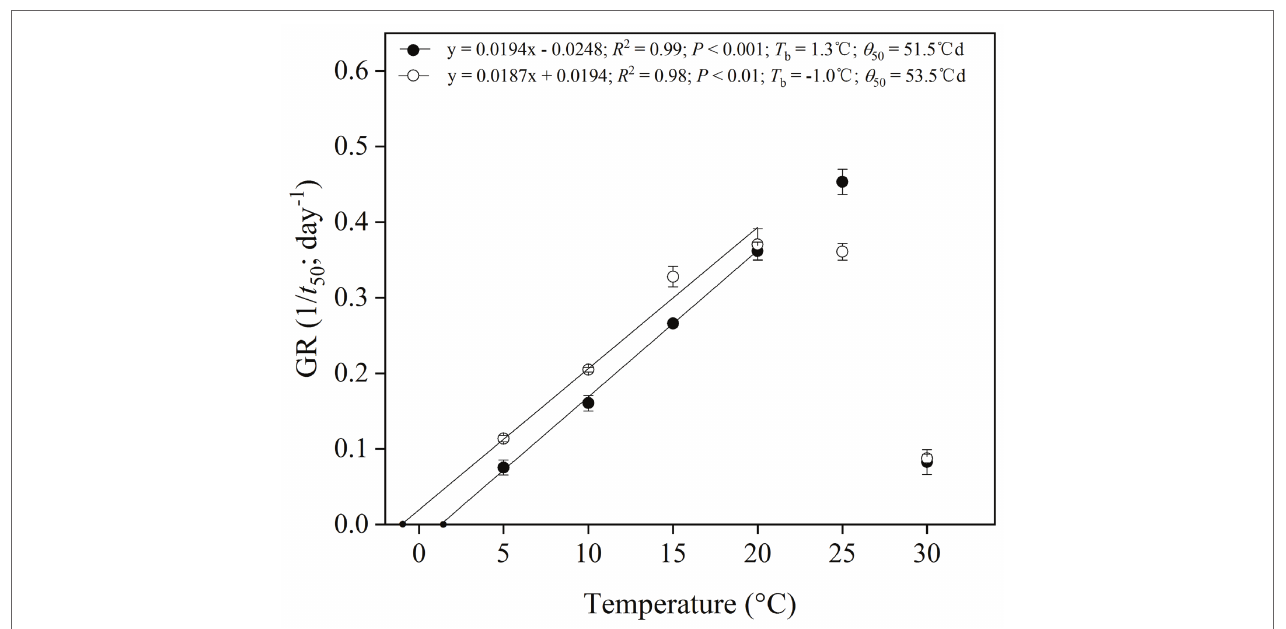
FIGURE 5 | Base temperatures ( T b ) and thermal times calculated for 50% germination percentiles of Primula secundiflora (solid circle) and Primula sikkimensis (empty circle) seeds, after cold stratification at 1 ° C in light for 4 weeks and incubation at 5–30 ° C (the sub-optimal temperatures: 5–25 ° C). Error bars indicate SE for three replicates of 20 seeds. Points correspond to the actual data and lines indicate the fitted line from the linear